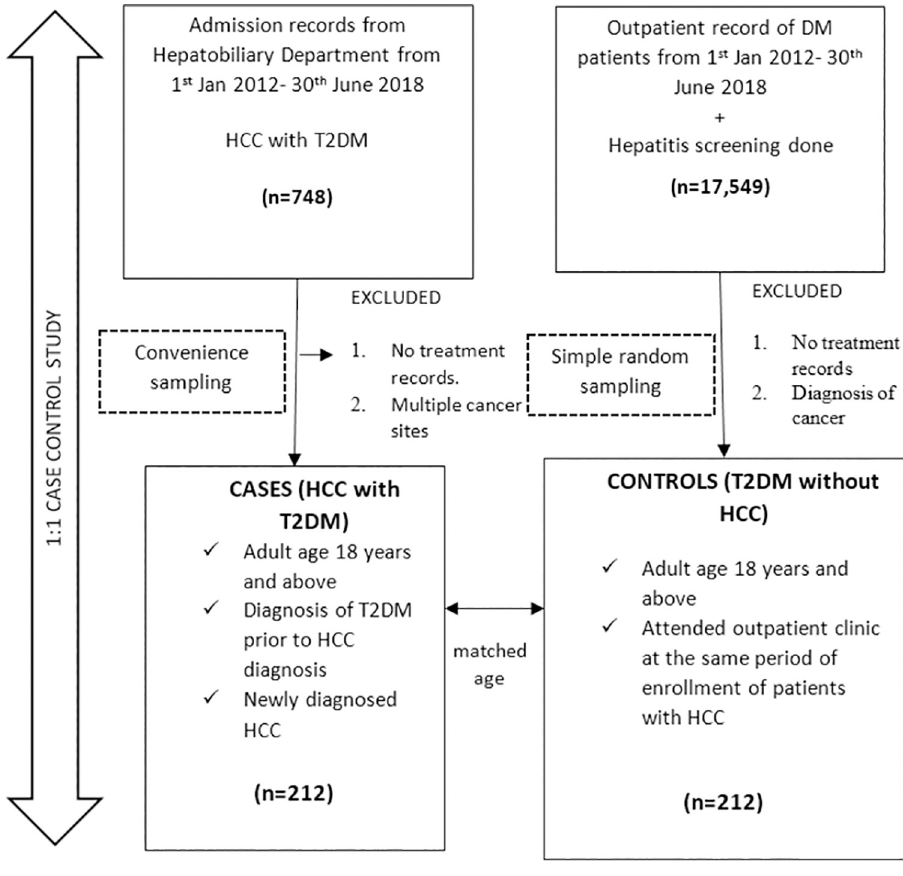
Fig 1. The overall study design